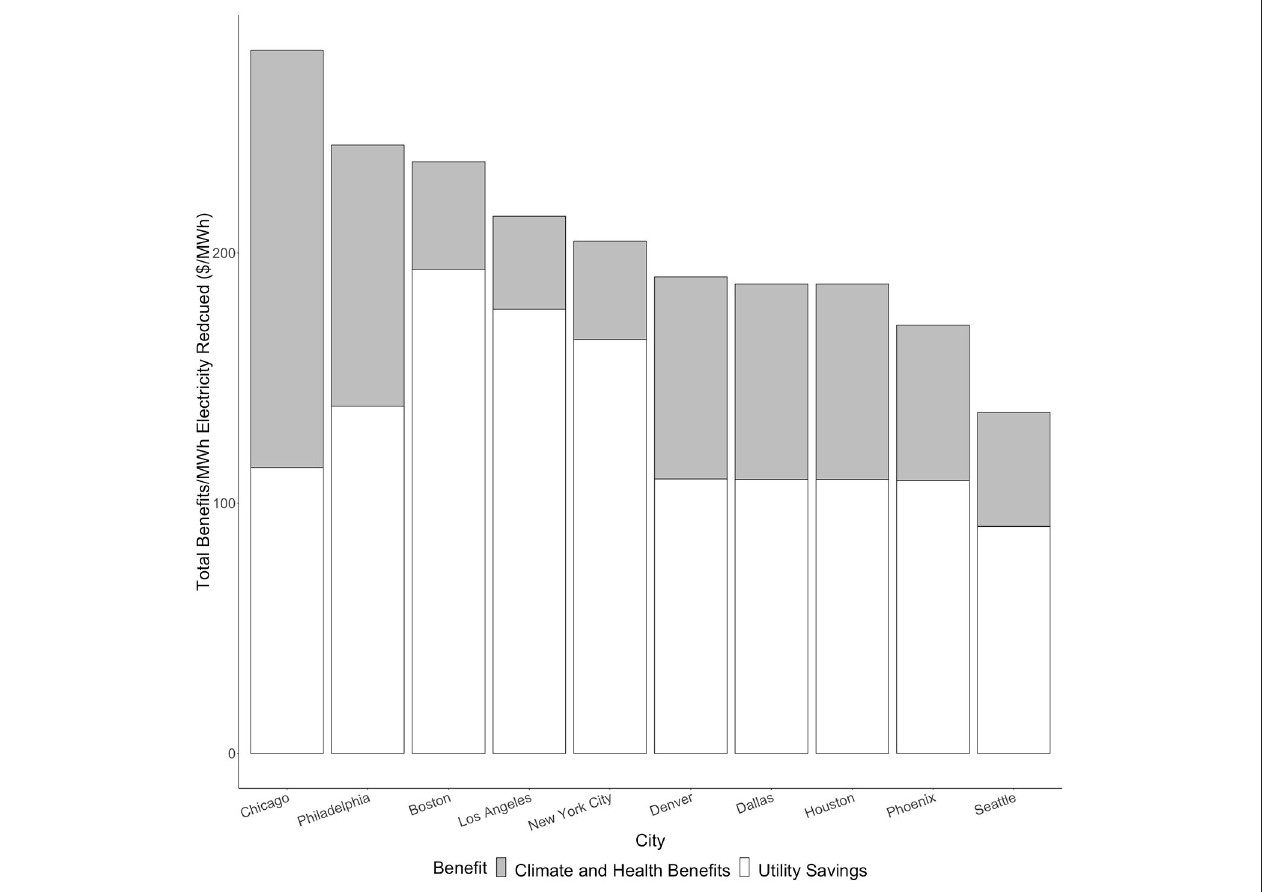
FIGURE 6 | Total climate and health (gray) and utility savings (white) benefits per MWh (2016 USD/MWh) of energy reduced from heat adaptation retrofits applied to detached single-family homes built from 1990 to 2010.